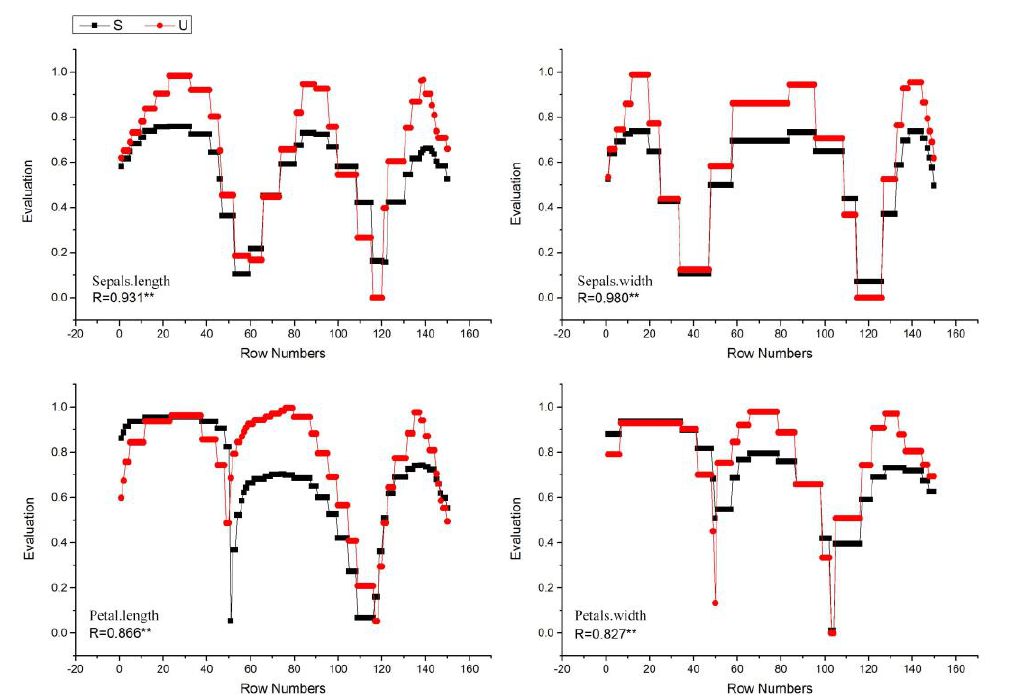
Figure 3. Comparison of individual